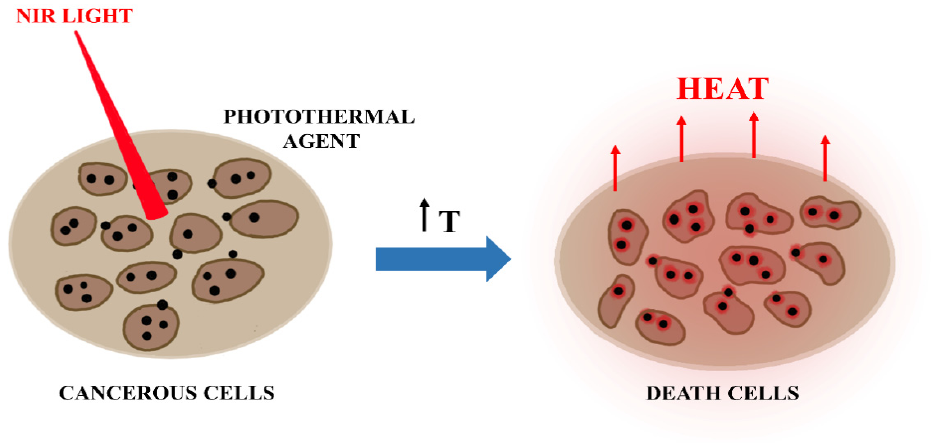
Figure 7. Mechanism of cell death induced by a photothermal agent in the presence of NIR light.